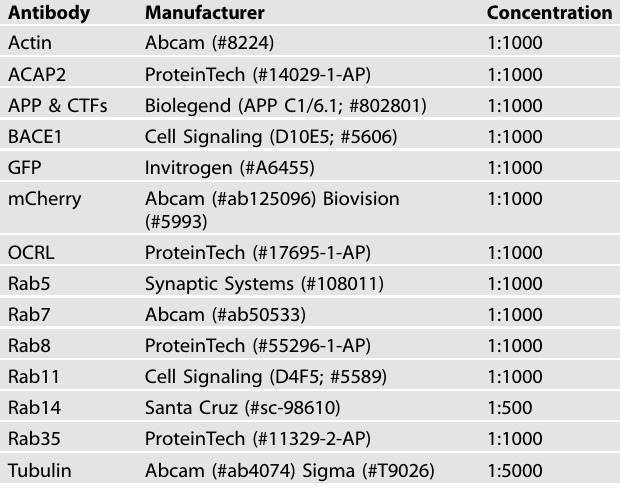
Table 1. List of antibodies used in this